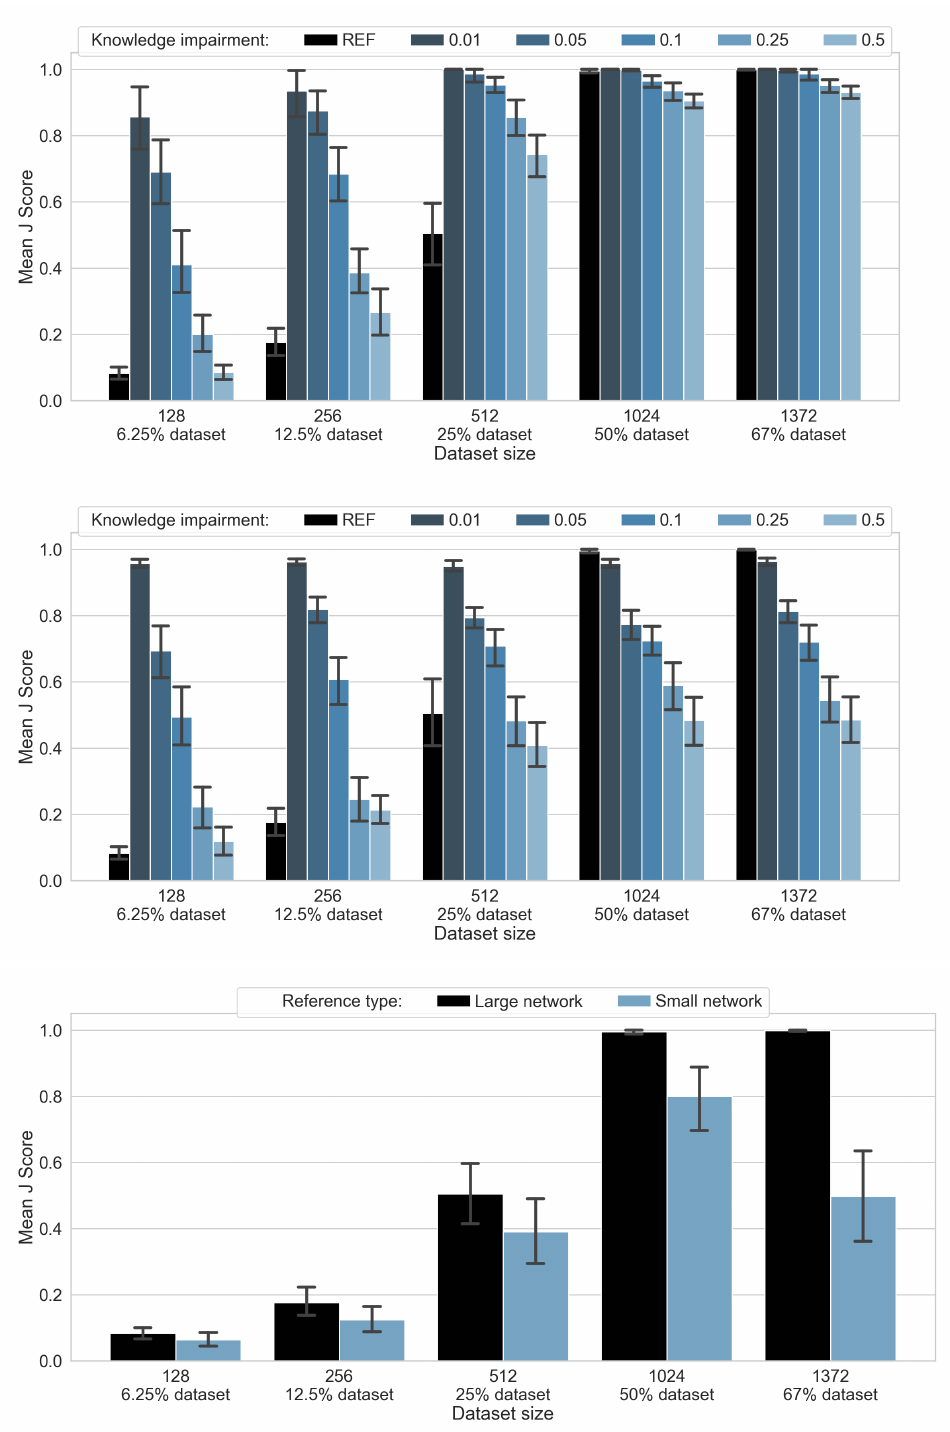
Figure 8. Adjusted classification accuracy scores for the hybrid network, L-neuron-only network and the two reference classical networks for different knowledge impairment levels and different training set volumes. ( Top ) Hybrid network performance ( J H ). ( Middle ) L-neuron-only network performance ( J L ). ( Bottom ) Performance of the reference neural networks. "REF" indicates performance of the reference, "larger" neural network. Confidence intervals of 95% are marked with